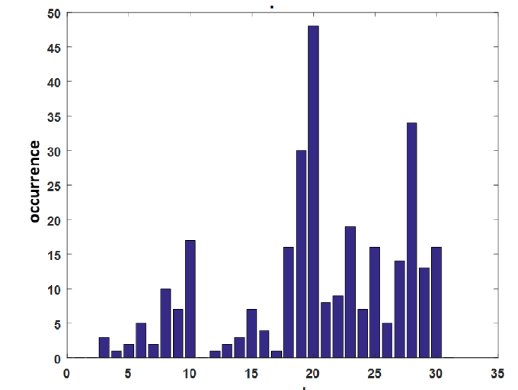
Figure 8. Distribution of tree occurrence as a function of the row for Orchard 1 as derived from the Harris transformed image.